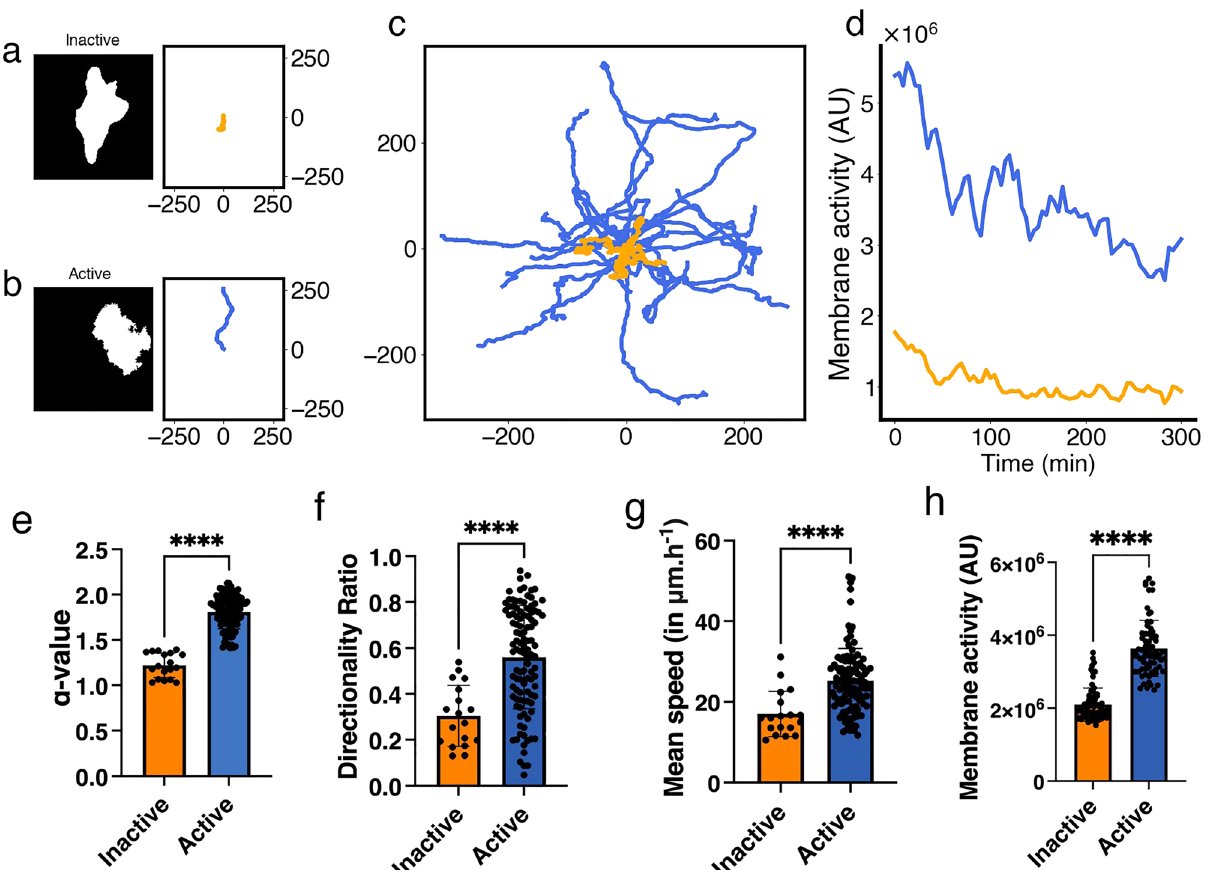
Figure 1. Characteristics of inactive and active classes of CHO-K1 cells exhibiting two distinct migration patterns detected using the α -value. ( a , b ) Representative binary masks (left) illustrating the shapes of CHO-K1 cells, along with their representative migration tracks (right). ( c ) Roseplots of a sample of CHO-K1 cell tracks (31 in total) colour-coded according to each class; orange: inactive, blue: active. ( d ) Time series of the level of membrane activity of two representative CHO-K1 cells, colour-coded according to each class. ( e ) Mean α -value of CHO-K1 cells in each class. ( f ) Directionality ratio (DR) for the entire trajectory of CHO-K1 cells in each class. ( g ) Mean instantaneous speed of CHO-K1 cells in each class. ( h ) Multiple measurements of the level of membrane activity, in term of pixel counts, of CHO-K1 cells in each class. Error bars indicate SEM. Black dots represent individual cells in e, f and g, while in h, the dots represent each time point of the tracks considered. Tracking data from Kiepas et al. 37 were used to produce panels c, e, f and g. Tracking data and cell images acquired for this study were used to produce panels a, b, d and h. There were n = 18 inactive cells and n = 108 active cells in panels e, f and g for a total of 126 cells tracked from timeseries data from 12 experimental replicates of cells imaged with transmitted light (brightfield), or diffuse light delivery for fluorescence imaging of paxillin-EGFP with 0.0245 mW power for 60 s exposure or 62 mW for 24 ms exposure as described in Kiepas et al. 37 ; in panel h, there were n = 3 inactive and n = 4 active